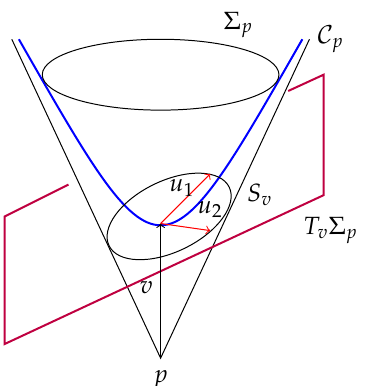
Figure 2. The directions u 1 , u 2 ∈ S v may have g v ( u 1 , u 1 ) (cid:54) = g v ( u 2 , u 2 ) , and therefore, the observer v could conclude c v ( u 1 ) (cid:54) = c v ( u 2 ) , i.e., the speed of light depends on the direction.